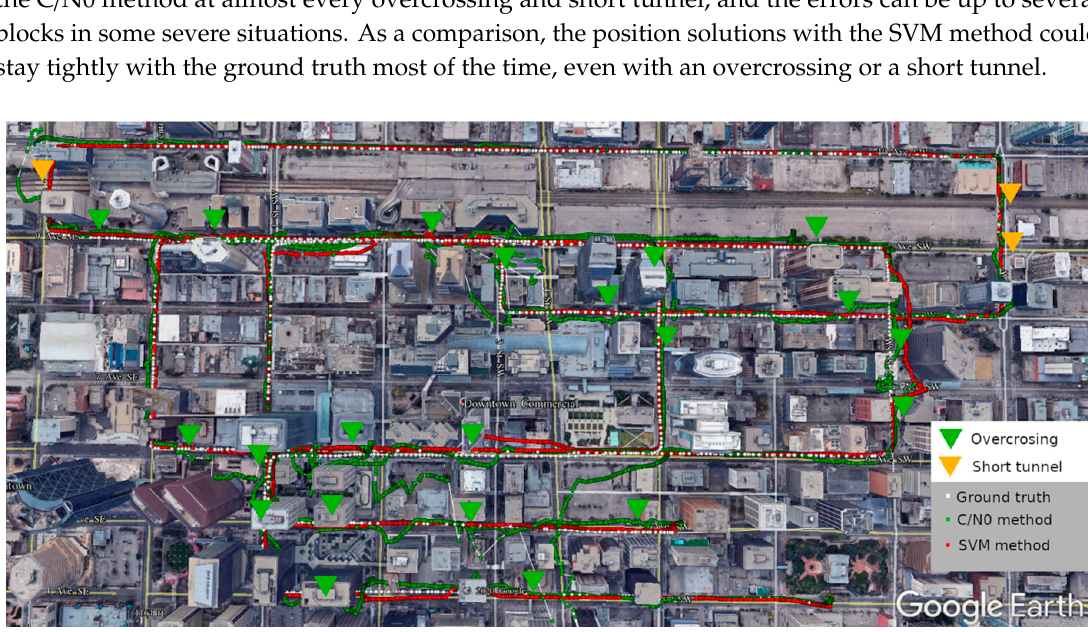
Figure 8. Google Earth view of the C/N0 weight scheme and SVM weight scheme based SFPPP track.